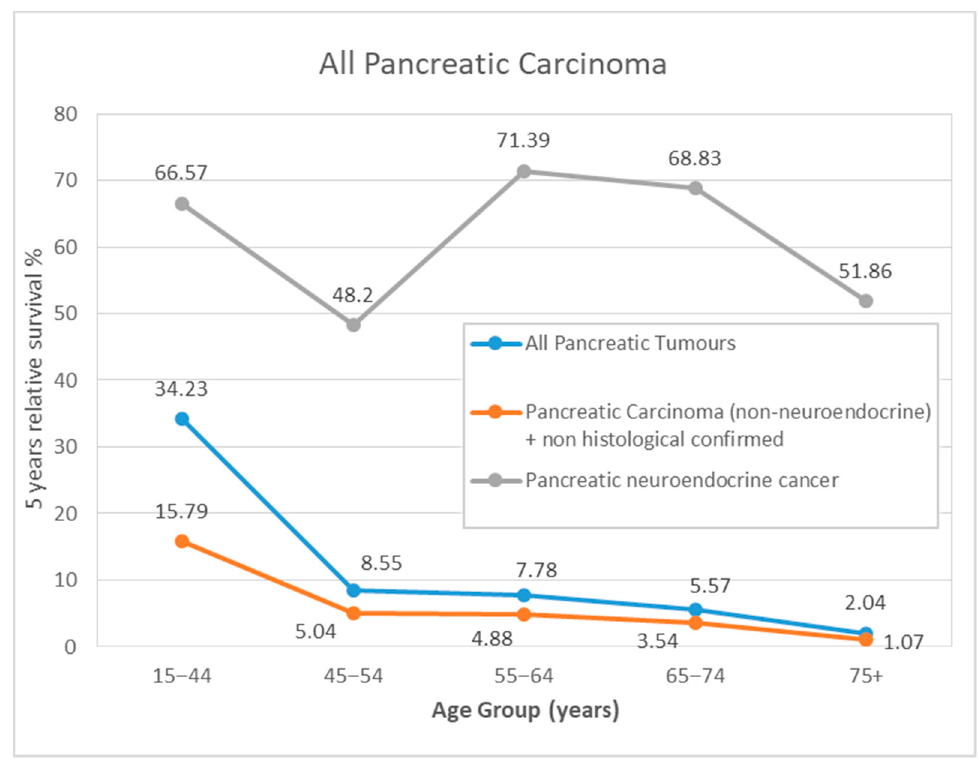
Figure 4. Age-specific period estimates of 5-year relative survival for all patients with pancreatic cancer diagnosed between 1994–2015, and according to histology.